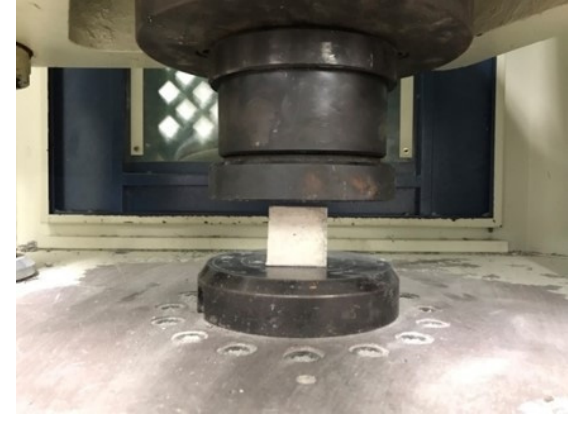
Figure 3. The illustration photo of compression test for cubic specimen.